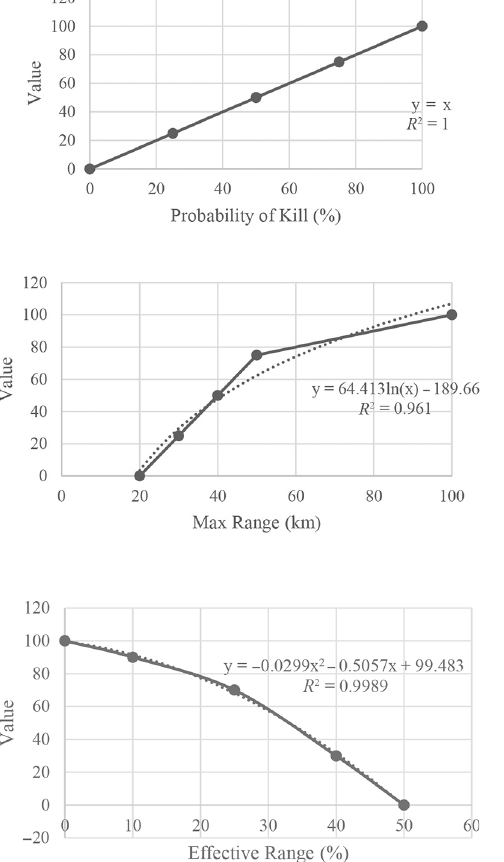
Figure 6. Effective range